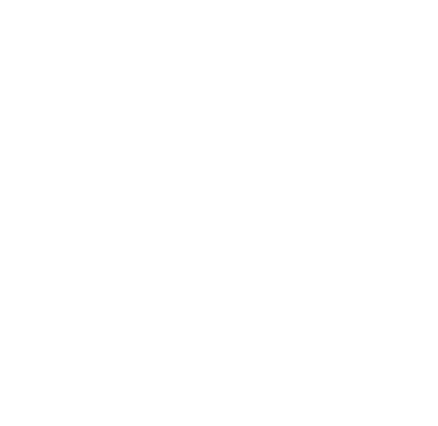
Figure 1. LAB and yeast content of cheese (log cfu/g). Abbreviations: M, mixed-fermentation cheese; S, single-strain-fermentation cheese.